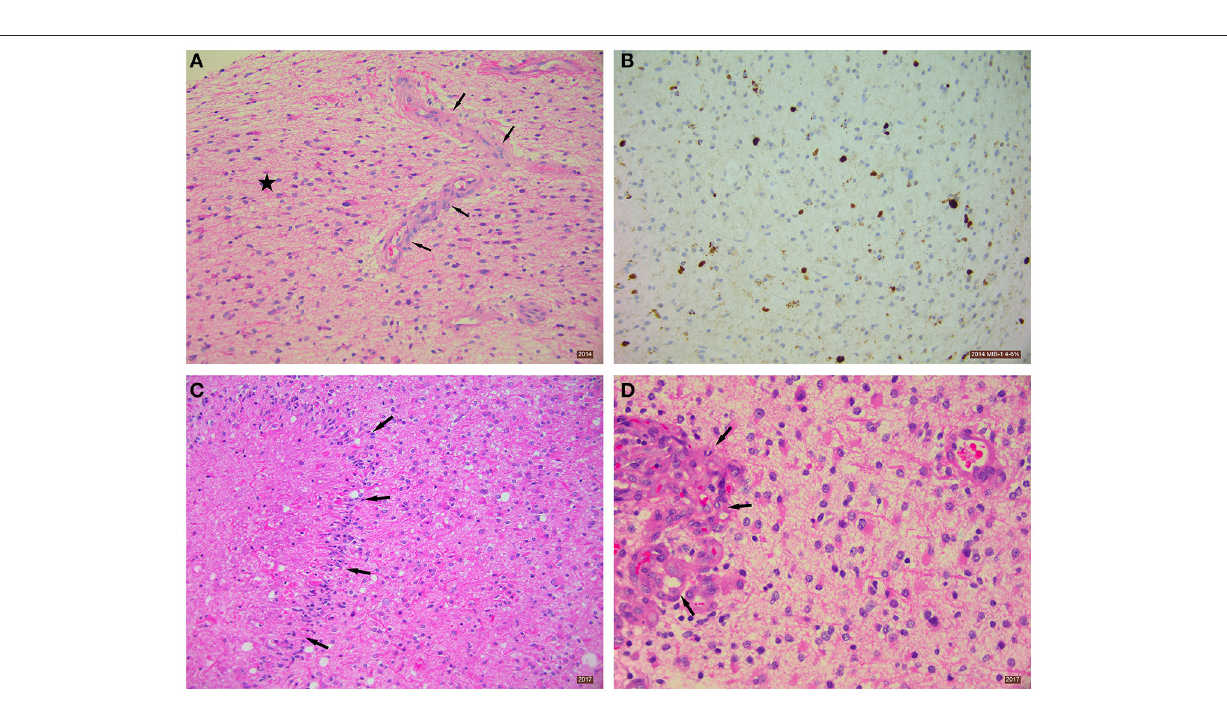
FIGURE 2 | Histopathological analysis of excised brain tumor tissue. (A) Diffusely-infiltrating astrocytic tumor (star) with focal microvascular proliferation (arrows). Tissue taken from 2014 biopsy, H&E stain 200x. (B) Immunohistochemistry using MIB-1 antibody showing a proliferation index of ∼ 4–6%. Tissue taken from 2014 biopsy, Immunostain 200x. (C) Section showing necrosis and palisading of astrocytic tumor cells around the necrotic area (arrows). Tissue taken from 2017 biopsy, H&E stain 200x. (D) Section showing glomeruloid vascular proliferation (arrows). Tissue taken from 2017 biopsy, H&E stain